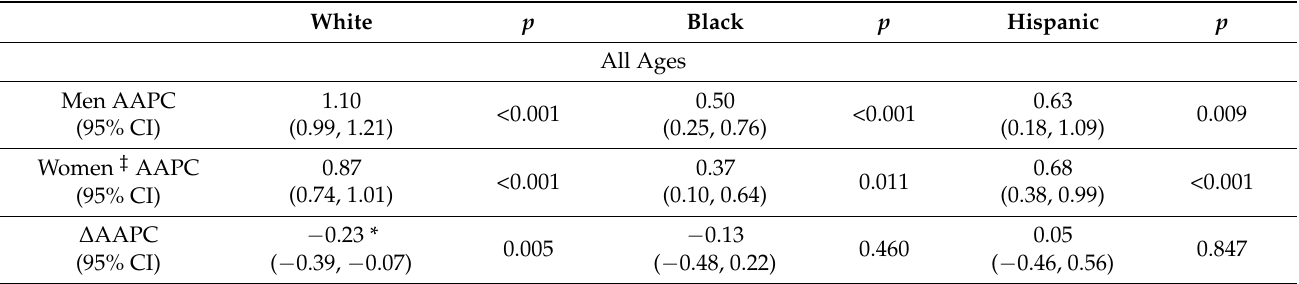
Table 2. Pancreatic cancer incidence time trends for White, Black and Hispanic patients from 2000 to 2018 stratified by age and